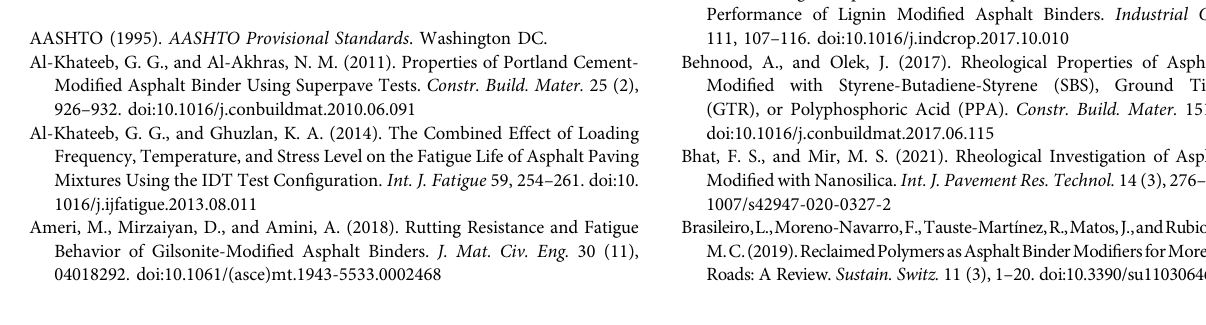
Frontiers in Built Environment |